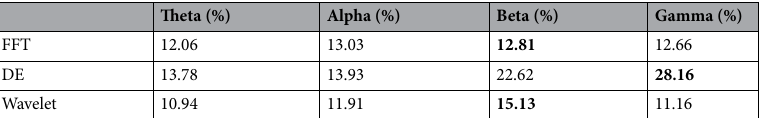
Table 1. Performance of hand-crafted features for EEG classification. Bold figures highlight the best frequency range for each method. While FFT and Wavelet show better results in the beta frequency range, DE has a significant boost in the gamma